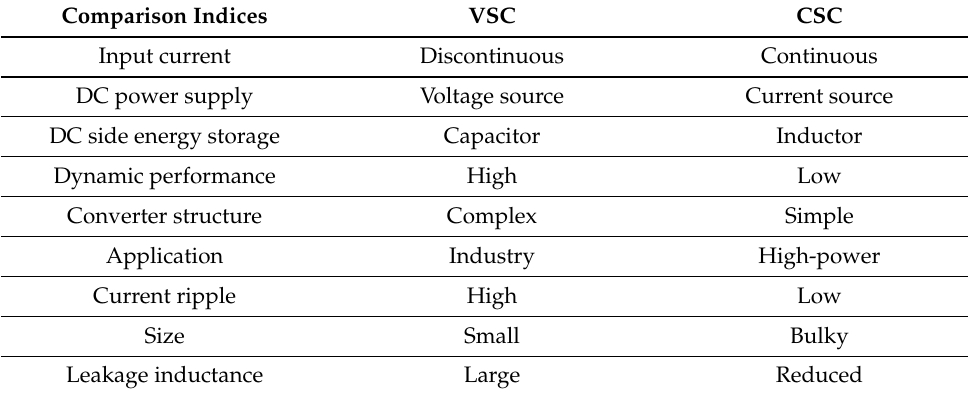
Table 5. Comparison indices between DC-DC CSC and